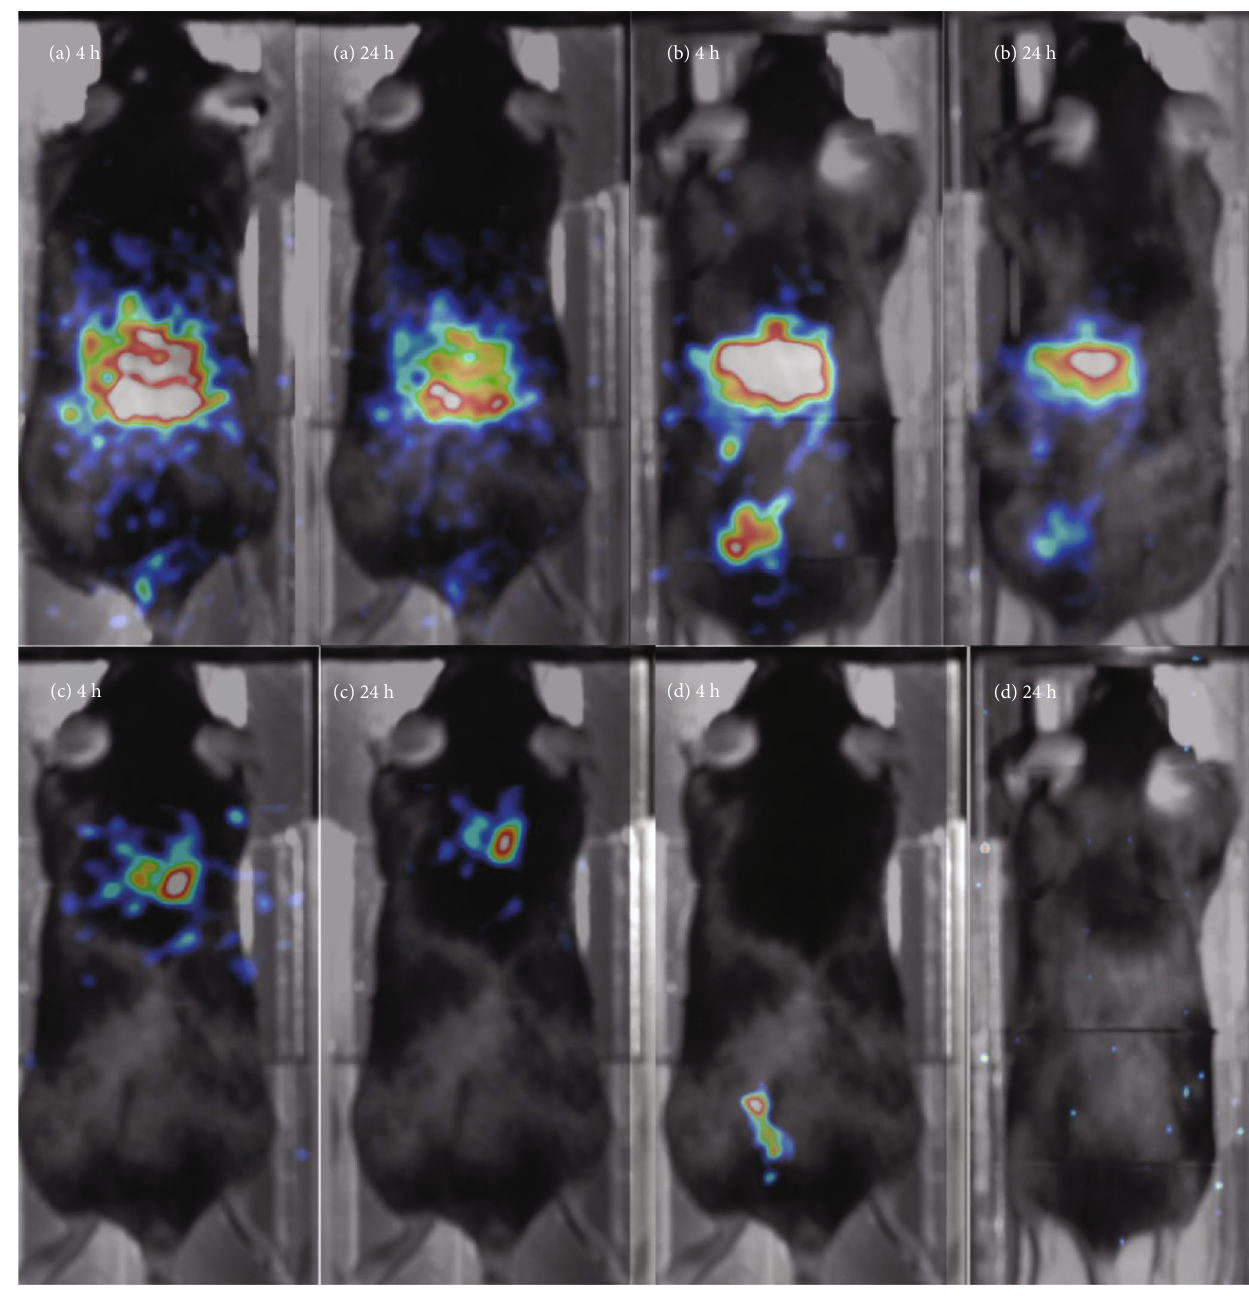
Figure 8: In vivo molecular screening for all tested routes with γ -eye ™ , for the 4 hrs and 24 hrs p.i.: (a) standard IV tail vein injection, (b) retro-orbital IV injection, (c) intratracheal installation, and (d) per rectum administration. Time point postinjection is shown on each image. All images are decay-corrected. Indicative images are shown ( n = 5 for each administration